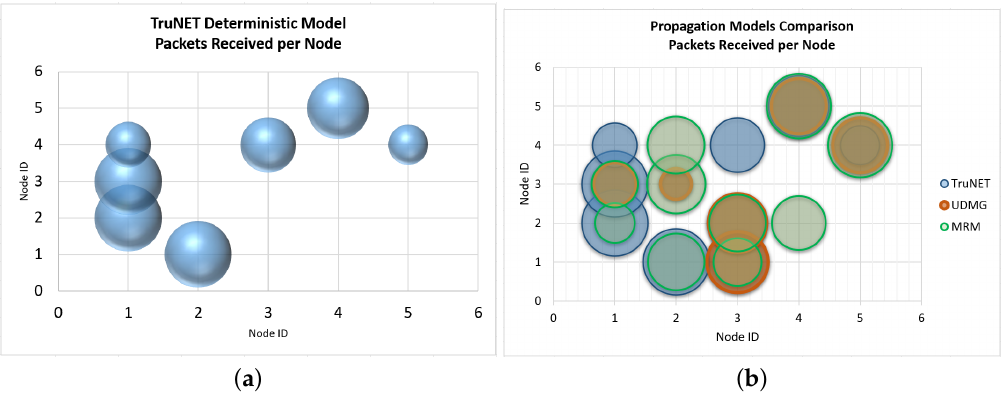
Figure 11. Packets: TruNET vs. Cooja built-in models simulation ( a ) TruNET Simulation; ( b ) Model Comparison